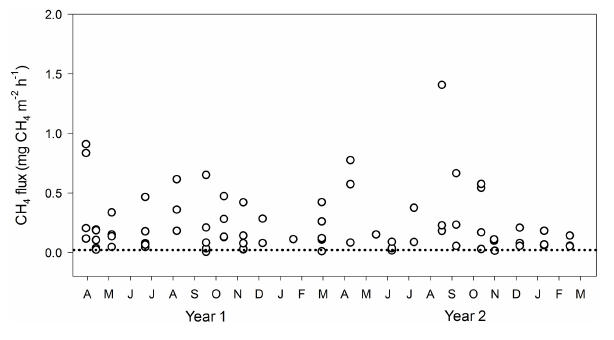
Figure 8. Measured CH 4 fluxes (mgCH 4 m − 2 h − 1 ) at Site A s (nutrient-poor, shallow-drained).